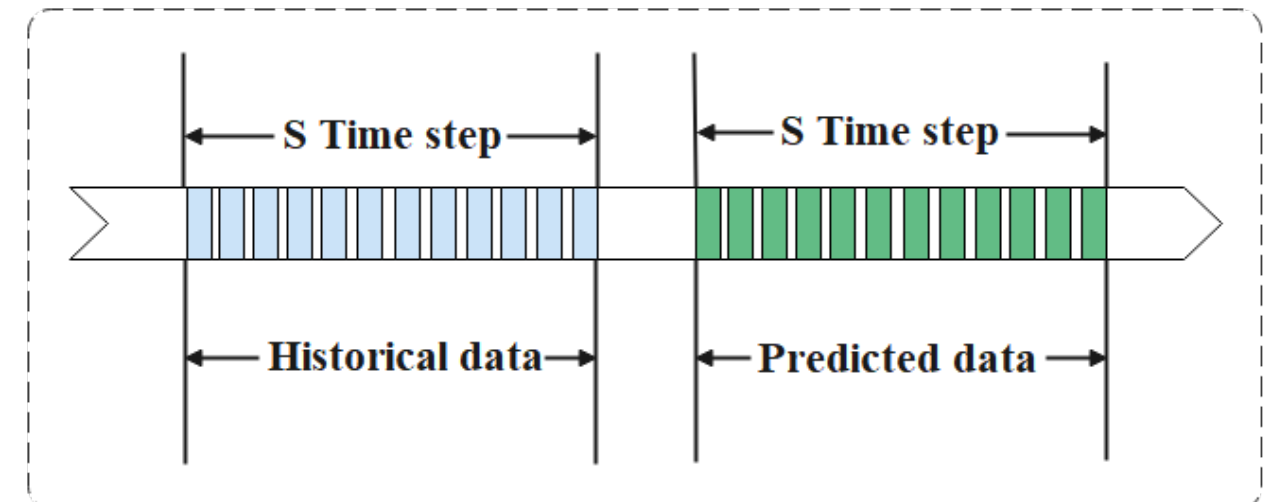
Figure 4. Traffic Congestion Data Forecast.